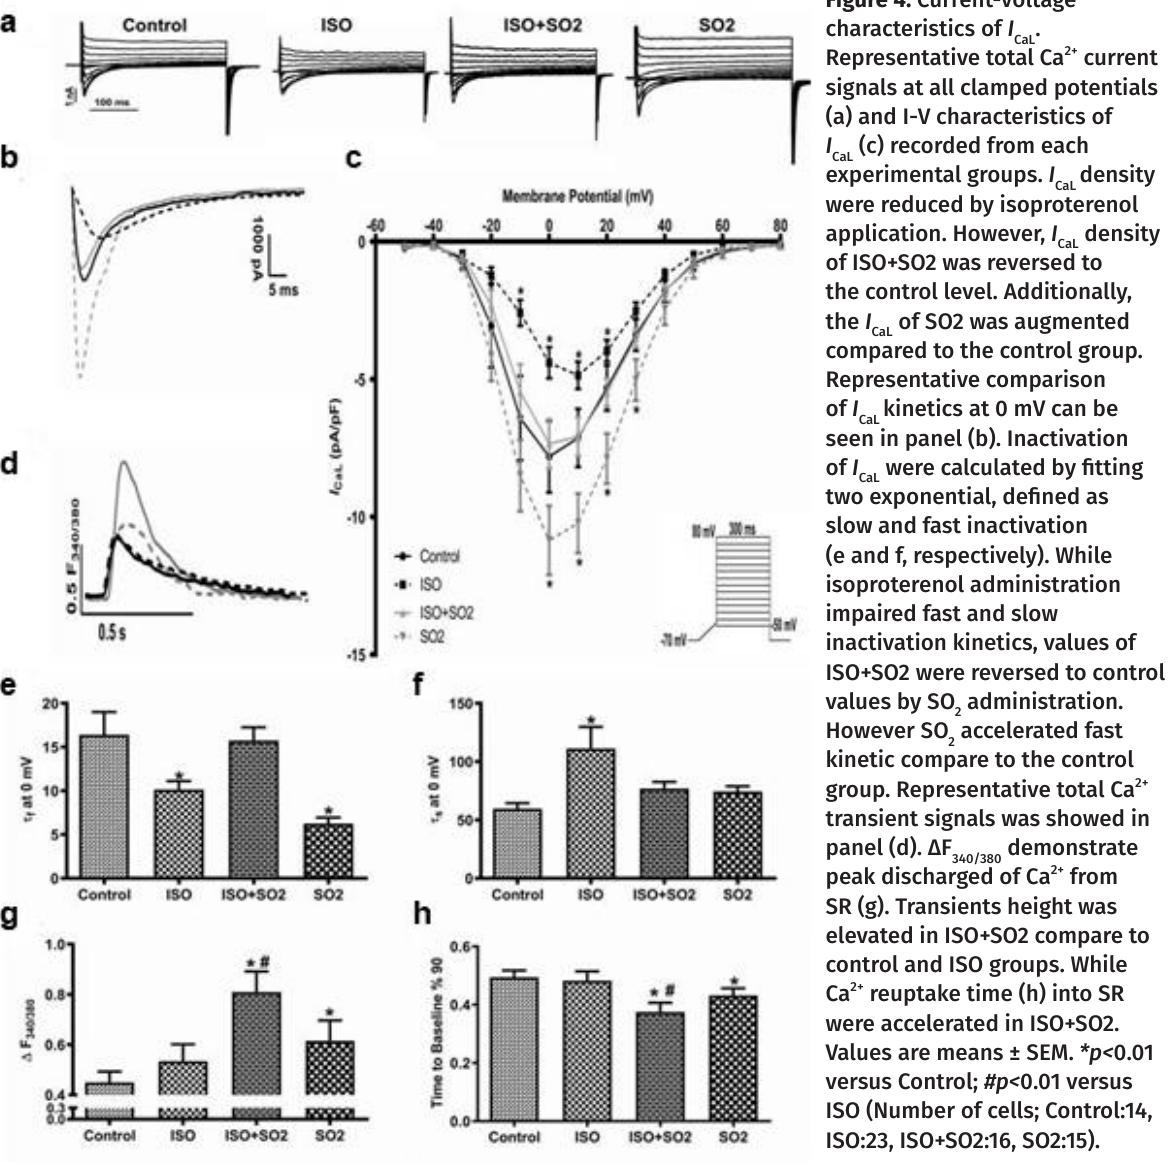
Figure 4. Current-voltage characteristics of I